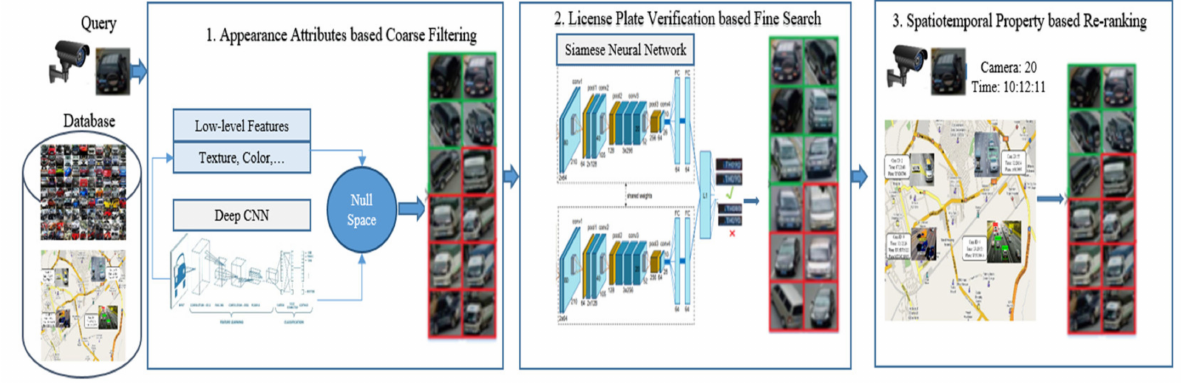
Figure 17. The architecture of the PROVID